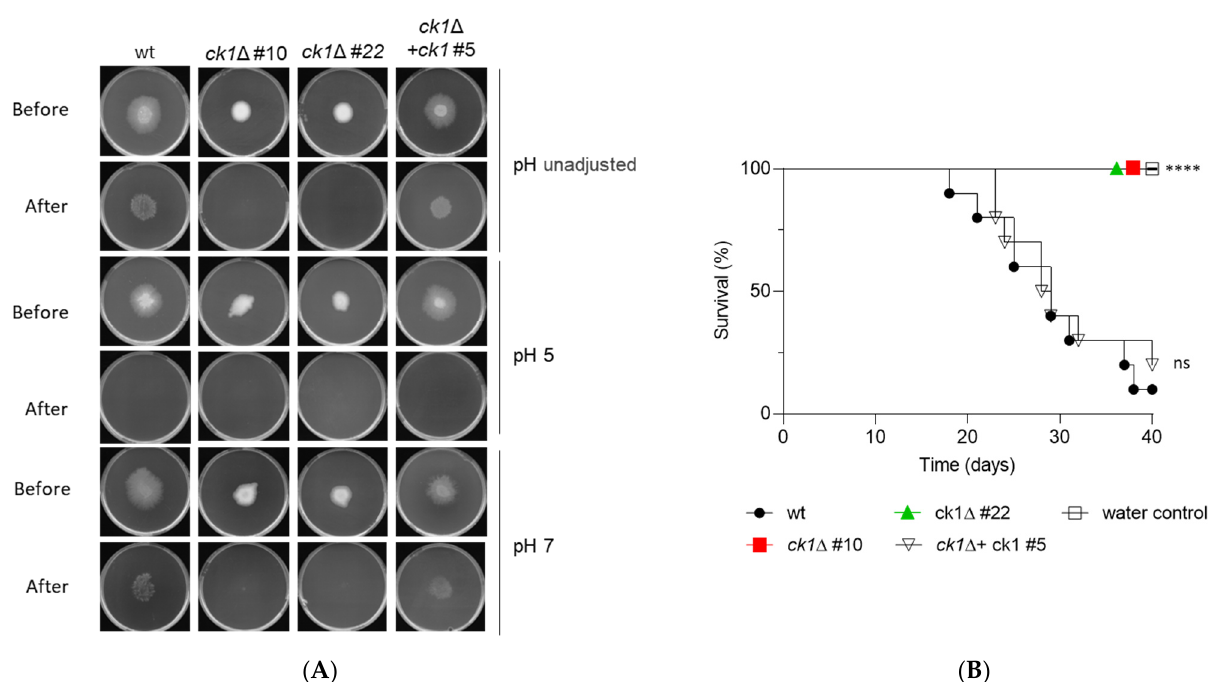
Figure 8. Ck1 is required for invasive hyphal growth and pathogenicity on tomato plants. ( A ) Aliquots of 5 × 10 4 fresh microconidia of the indicated strains were spot ‐ inoculated on top of cellophane membranes placed on MMA plates that were either unbuffered of buffered to pH 7.0 or 5.0 with 100 mM MES. Plates were imaged after 3 days incubation at 28 °C (before), then the cellophane membrane with the fungal colony was removed, and plates were incubated for an additional day to visualize the presence of mycelium on the plate, indicative of penetration through the cellophane (after). The images shown are representative of three independent experiments, each with three plates per treatment. ( B ) Kaplan–Meier plots showing the survival of tomato plants (cv. Moneymaker) inoculated by dipping roots into a suspension of 5 × 10 6 fresh microconidia/mL of the indicated fungal strains. Survival of tomato plants was recorded for 40 days. Ten plants were used per treatment. p < 0.0001 (****) versus wt according to the log ‐ rank test. The data shown are from one representative experiment. Experiments were performed three times with similar results.